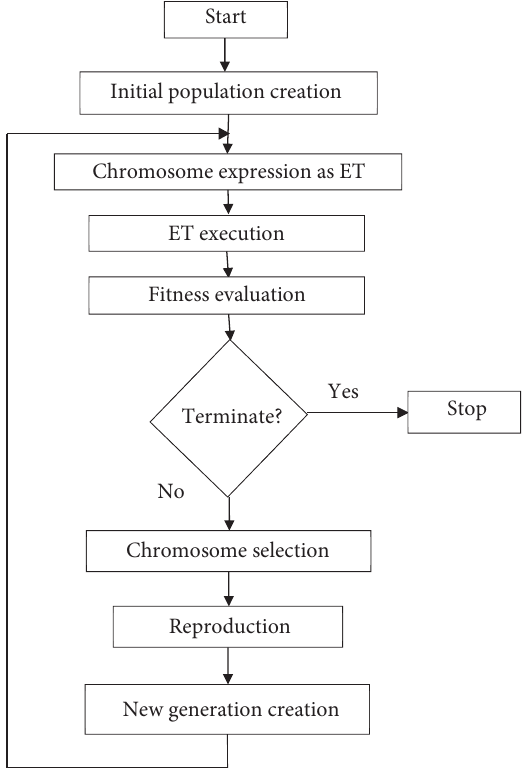
Fig. 5. GEP algorithm